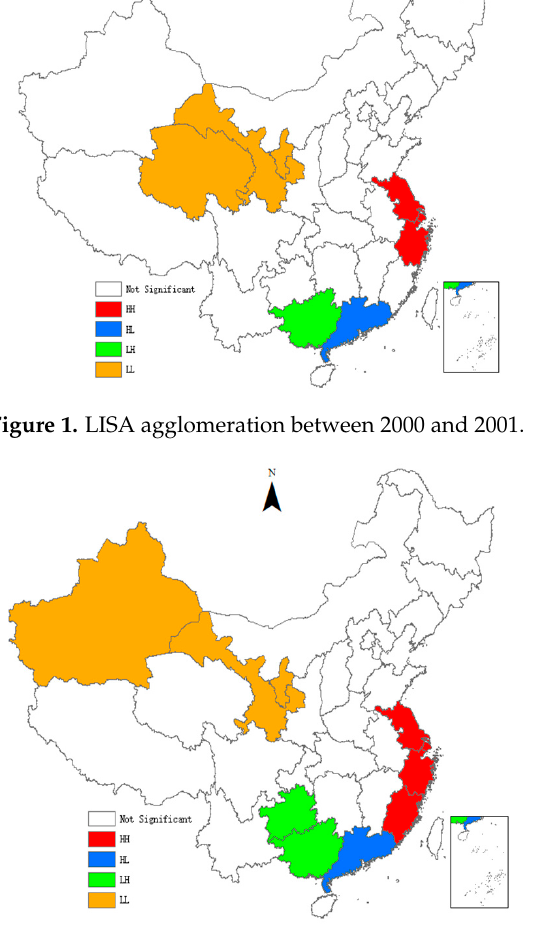
Figure 2. LISA agglomeration between 2005 and 2006.